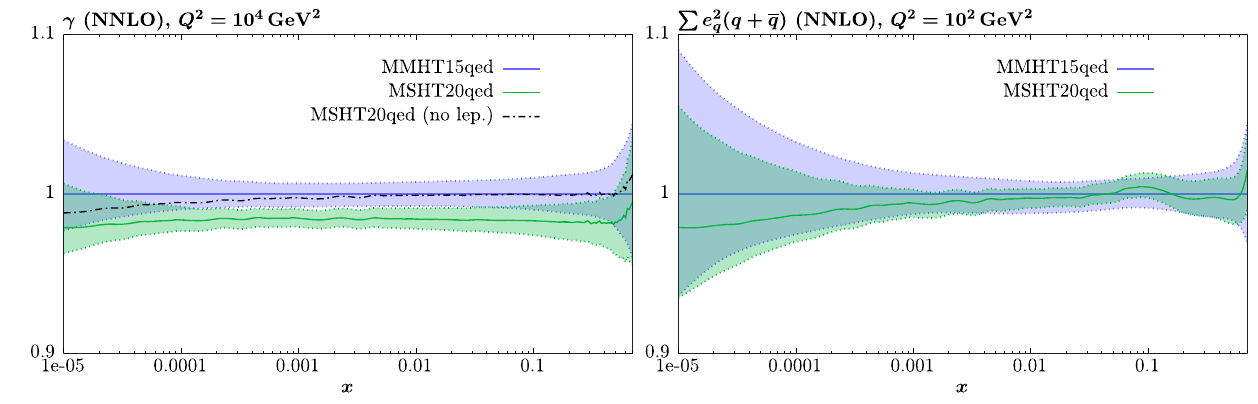
Fig. 5 The ratio of the (left) photon and (right) charge-weighted singlet distributions (with uncertainties) at Q 2 = 10 4 GeV 2 , resulting from fits to the MSHT20 dataset, to the MMHT15qed case